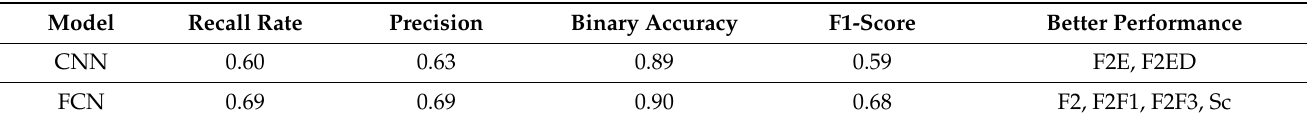
Table 3. Comparison of model